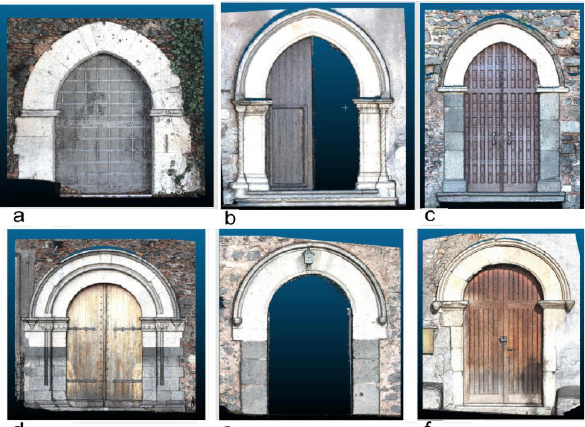
Figure 1. Catalan-Aragonese gothic portal point clouds: a) lateral portal of S. Antonio Abate church (Mascalucia); b) S. Maria di Josaphat church (Paternò); c) S. Francesco convent (Paternò); d) main portal of S. Antonio Abate church (Mascalucia); e) S. Maria Annunziata church (Mompilieri); f) S. Maria della Catena church